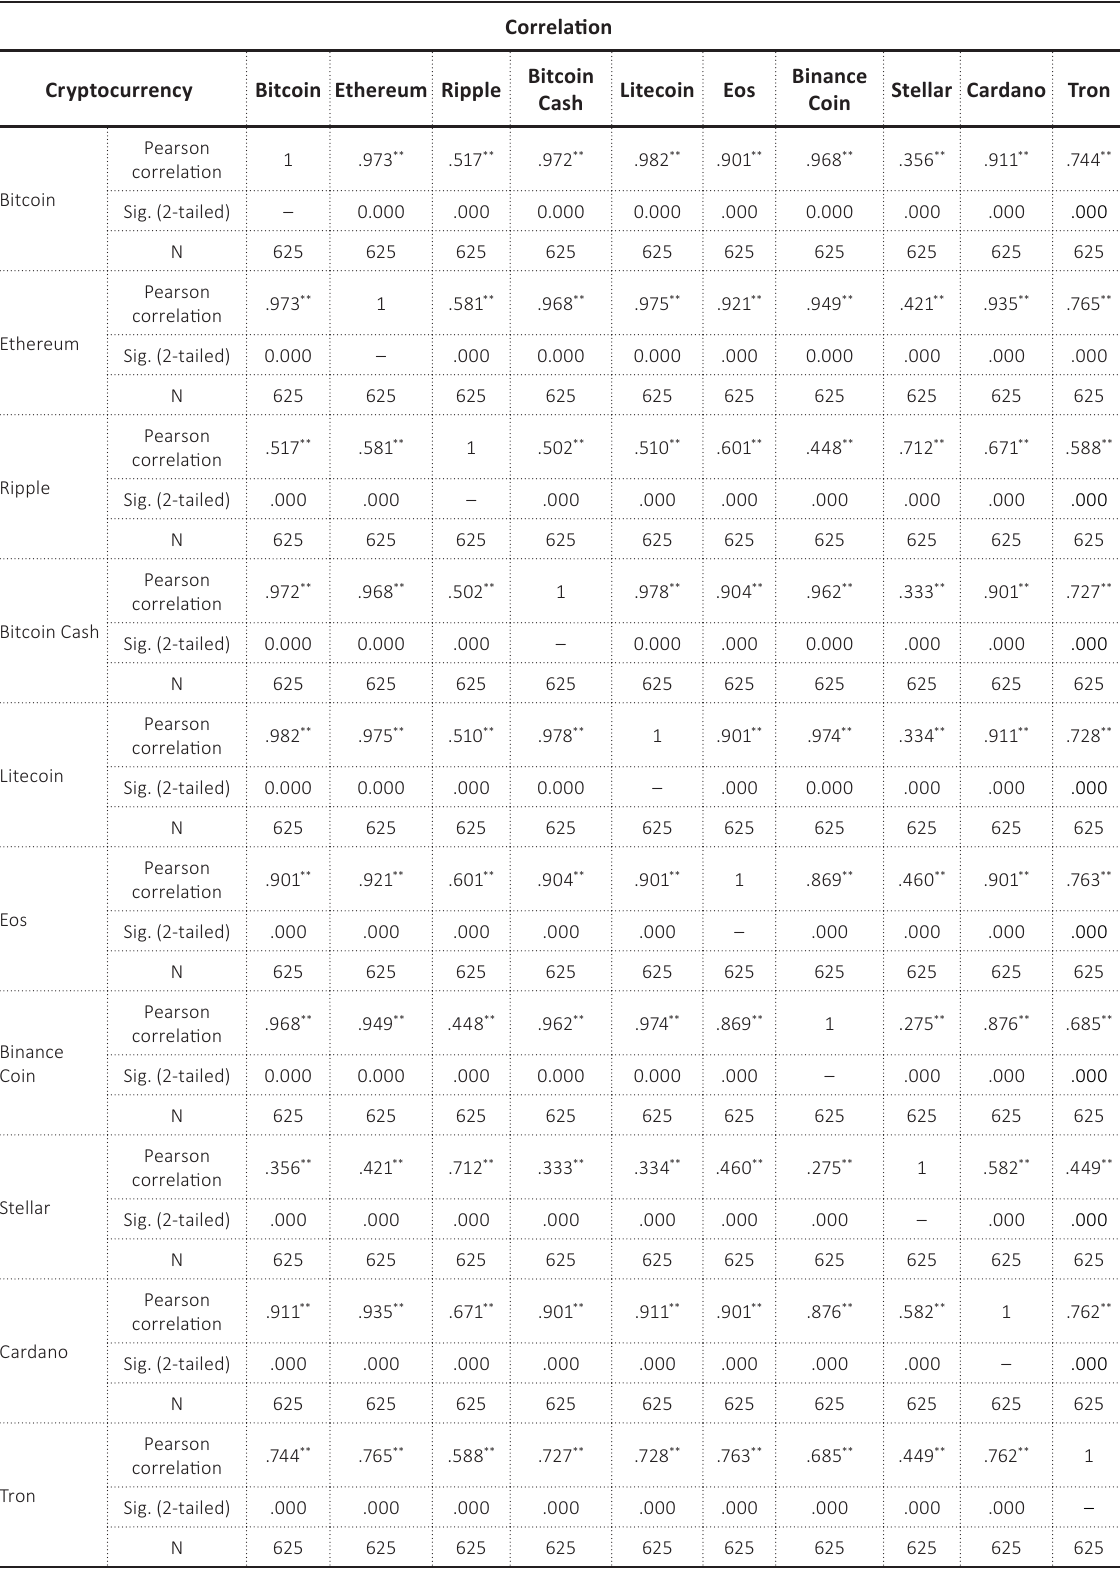
Table 3. Pearson correlation coefficients between cryptocurrency pairs for the period of decreasing prices (daily